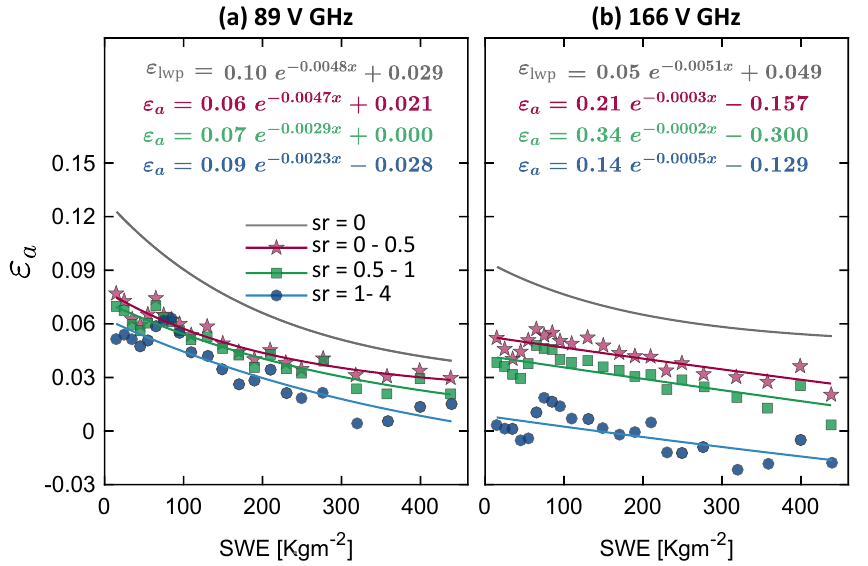
Figure 6. Atmospheric emissivity, ( ε a ) for different snowfall rate intervals over dry snow cover for LWP = 150–200 gm − 2 at GPM high-frequency channels 89 GHz ( a ) and 166 GHz ( b ). Note that the dark gray curve is associated with sr = 0 mmh − 1 , which is the exact same curve (solid dark gray with yellow markers) in Figure 5. It is shown here again for making easier comparisons of ε a when sr > 0 and ε lwp